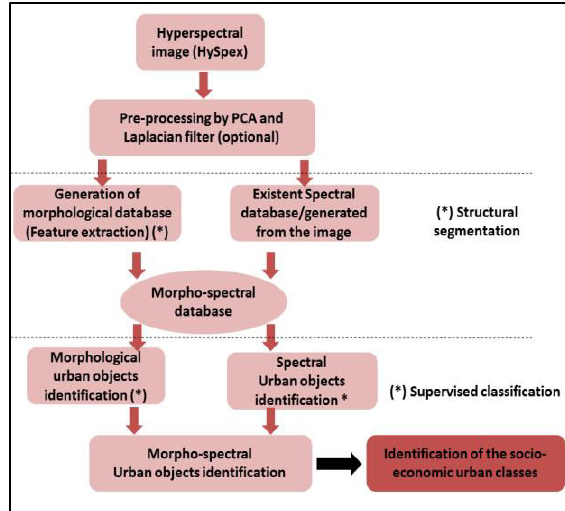
Figure 1. Image processing sequence